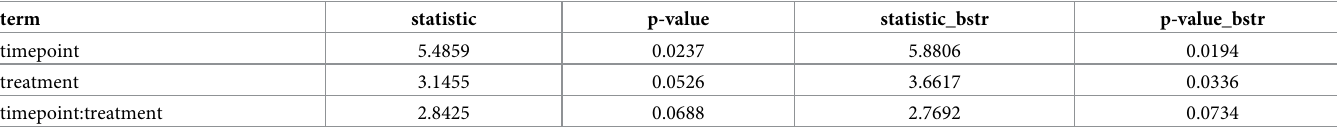
Table 4. Significance of F:B differences between treatments and timepoints, and their interaction. statistic_bstr and p-value_bstr are the median test statistic and p- value from the bootstrapping distribution of 1000 replicates of the linear model.